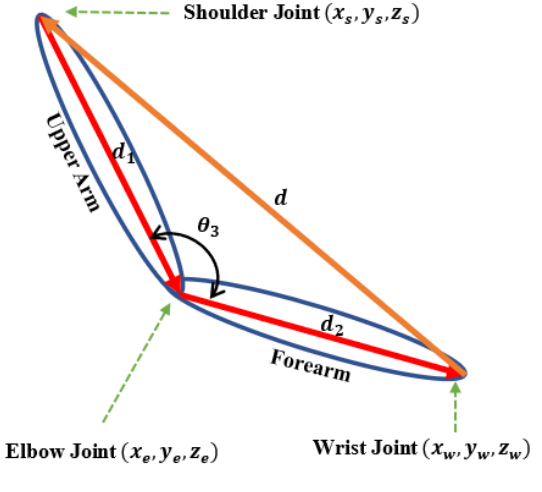
Figure 8: Joint angle θ 3